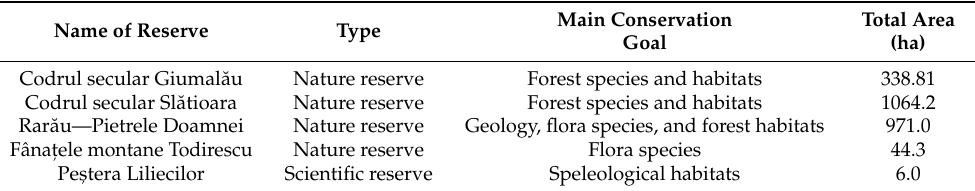
Table 1. Summary of reserves inside the study area.